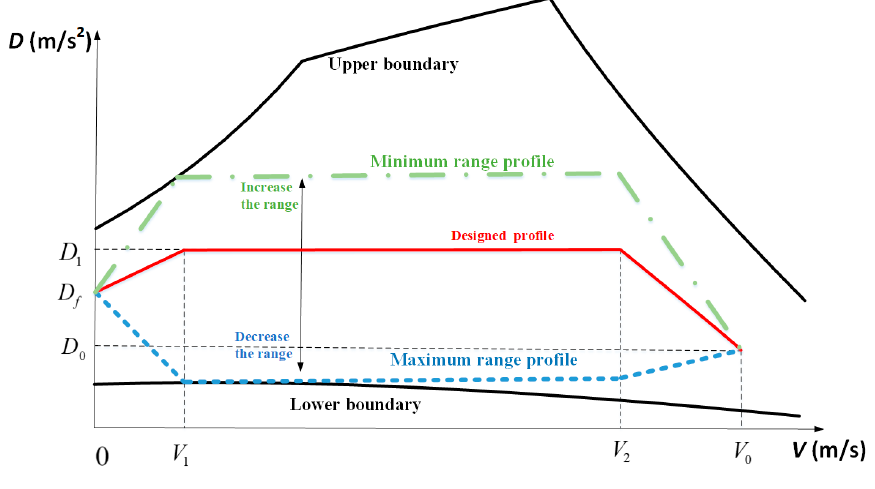
Figure 1. The D-V designed profile schematic.